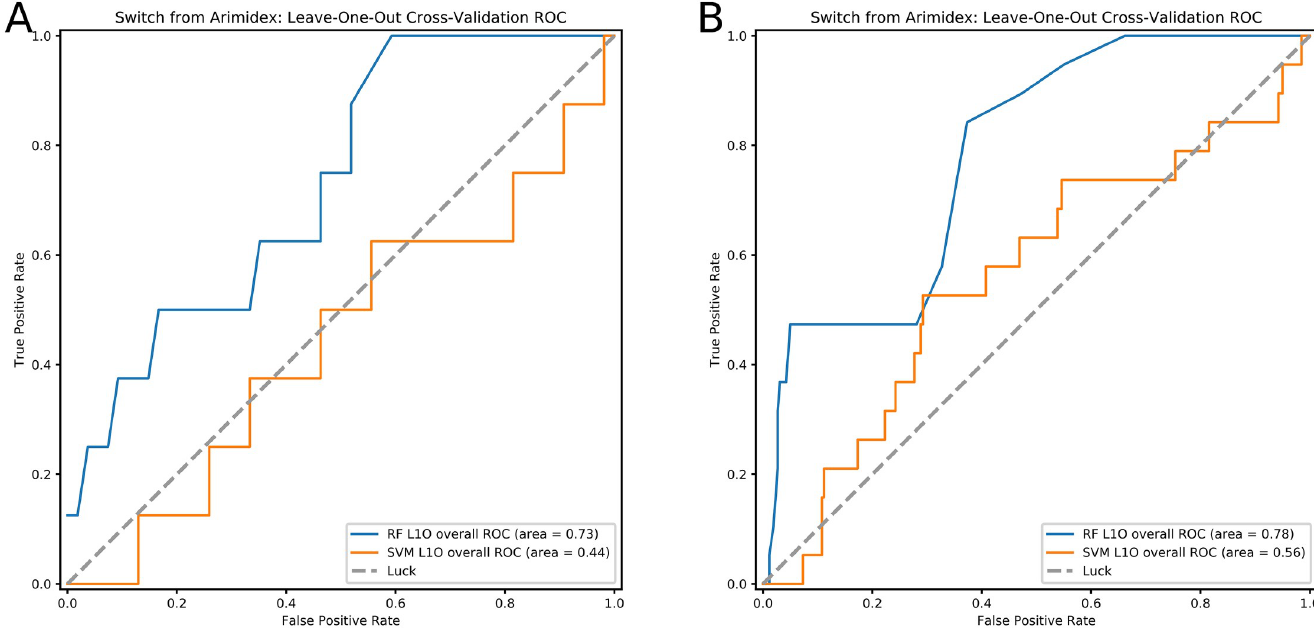
Fig 4. Cross-validation prediction results for non-response to anastrozole. (a) shows results for non-response to anastrozole with all available TCGA samples, and (b) shows prediction results restricted to UPMC patients.